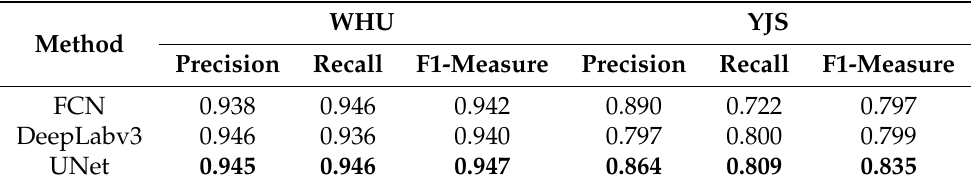
Table 4. Demographic prediction performance comparison by three evaluation metrics.Bald repre- sents best record and is the network structure we finally adopted.